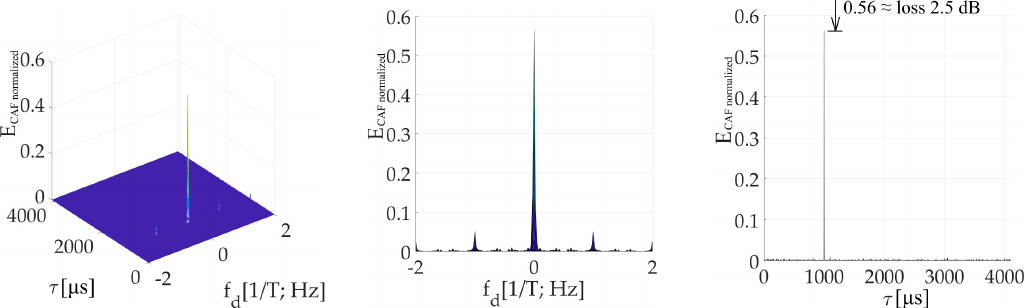
Figure 14. Resulting CAF of the mPCA pre-correlation processing of SC using the SBZP, for τ = (1/4) T . CAF ( left ), Dopler shift domain ( middle ), Code phase domain ( right ).